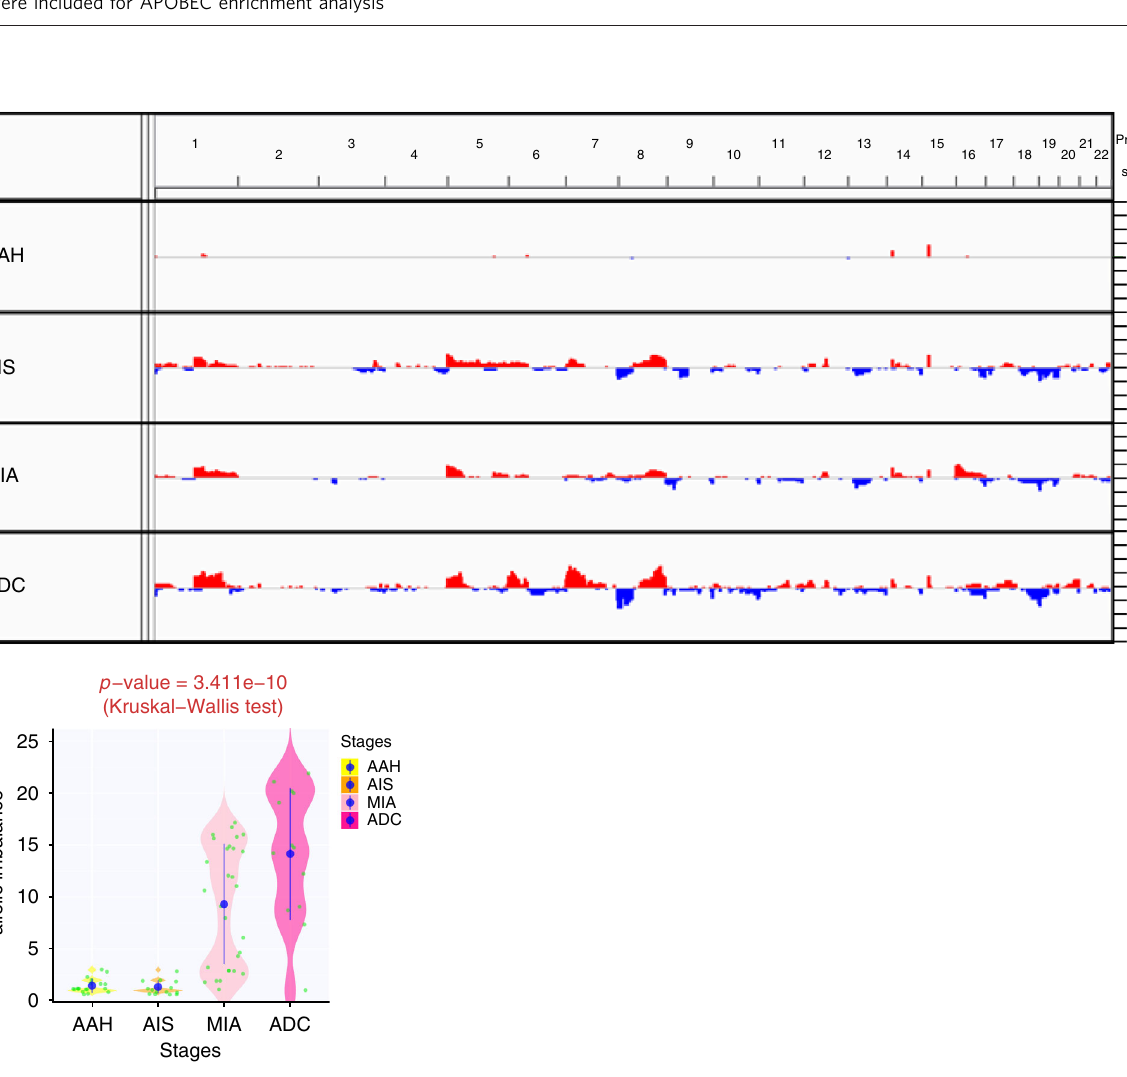
Fig. 2 Macroevolution from AAH to ADC at chromosomal level. a The somatic copy number aberrations across the genome. Each row represents all lesions grouped by histologic stage. Copy number gains, de fi ned as the mean log2 ratio (IPN versus germ line DNA) >0.3 of all lesions by each given stage, are represented as red bars. Copy number losses, de fi ned as the mean log2 ratio (IPN versus germ line DNA) ≤ 0.3 of all lesions by each histologic stage are represented as blue bars. The height of the bars is proportional to the fraction of IPNs showing copy number gains or losses at corresponding chromosomal regions. b The allelic imbalance. Each green dot represents the number of AI events in each IPN and the blue dots represent the mean number of AI events detected in IPNs of each histologic stage. The difference between all stages was assessed by Kruskal – Wallis H